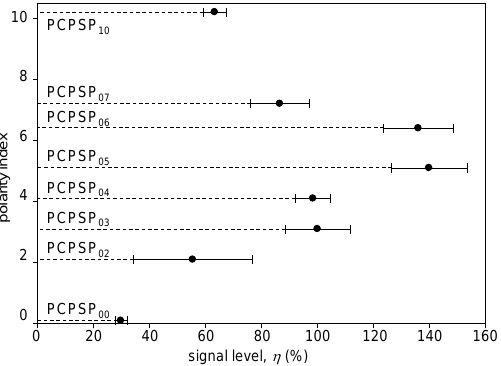
Figure 7. Relationship between the signal level,  (%), and the polarity